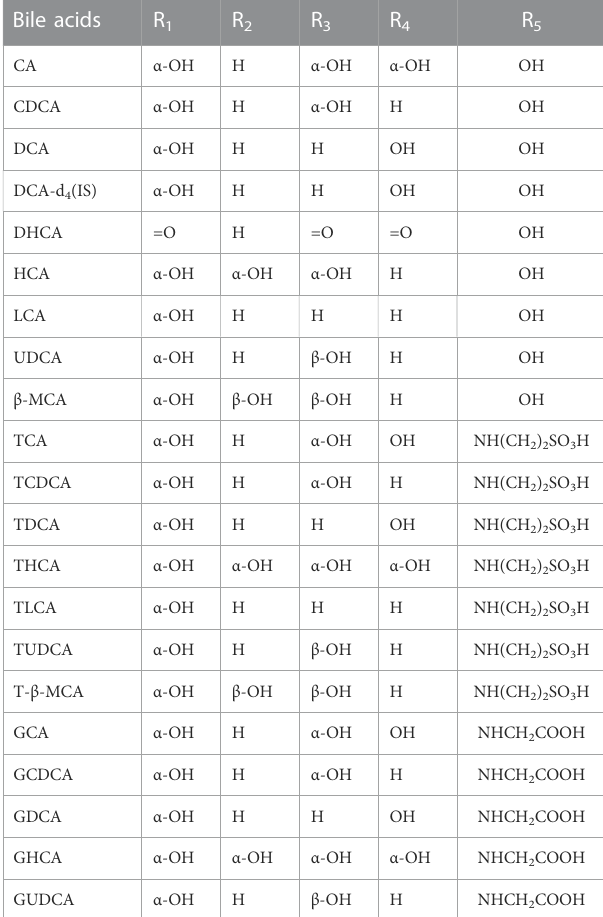
TABLE 1 The substituent group of different bile